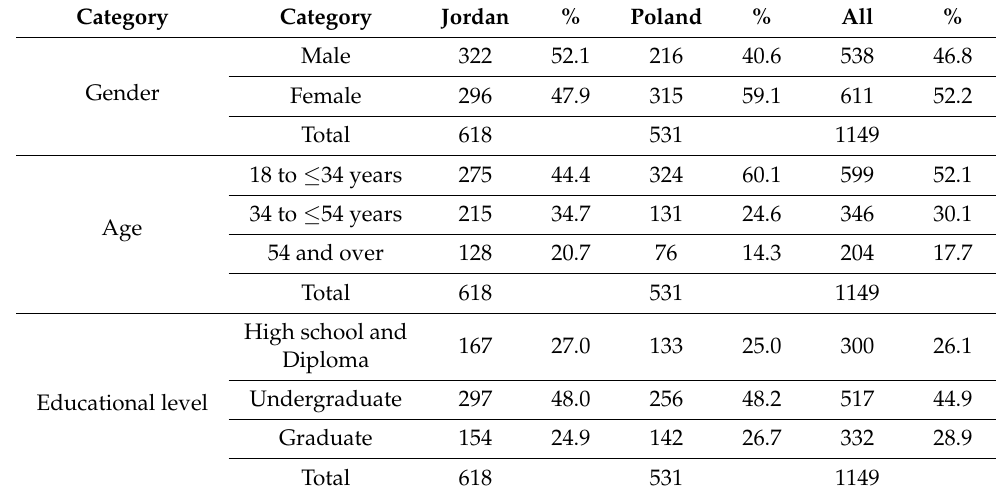
Table 1. Sample profile ( N =